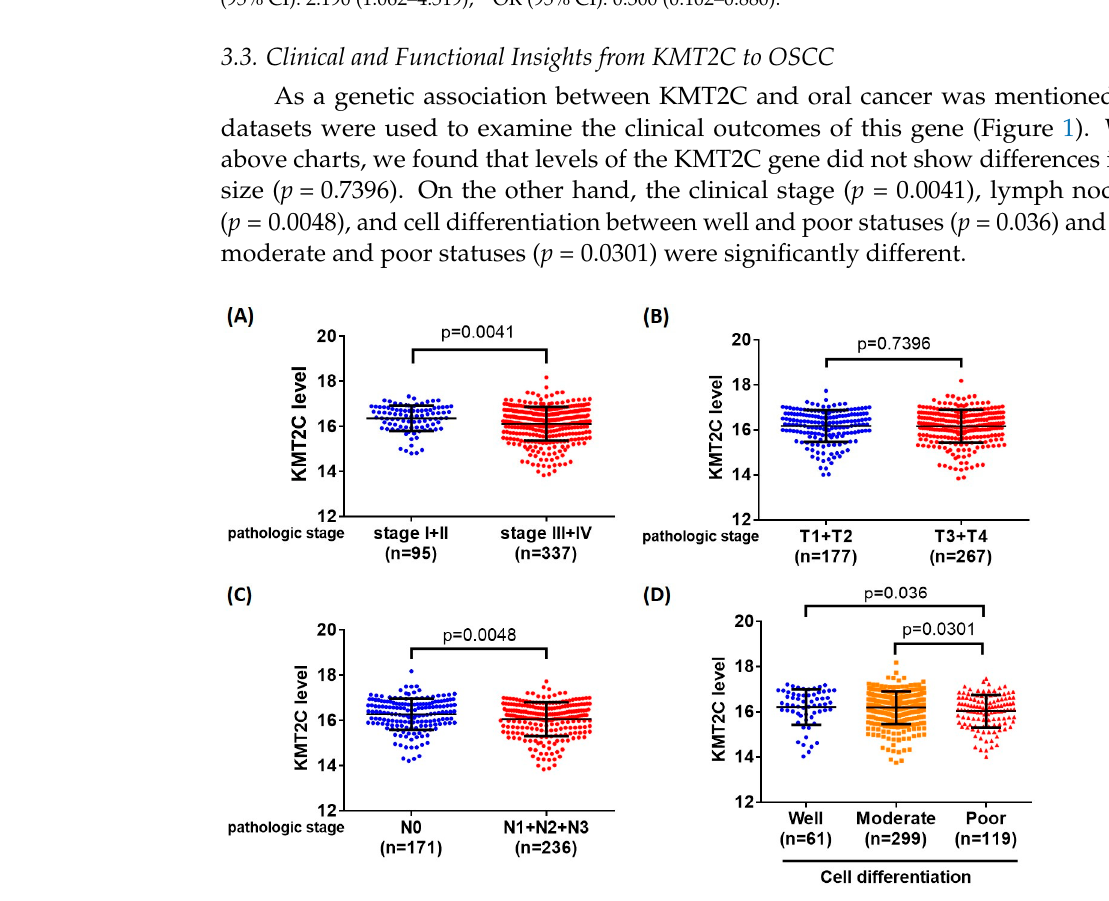
Figure 1. KMT2C expression levels were associated with clinicopathological parameters in HNSCC. The correlation between KMT2C expression and ( A ) clinical stage, ( B ) tumor size, ( C ) lymph node metastasis, and ( D ) cell differentiation of HNSCC in TCGA database. p -value < 0.05 is statistically significant.